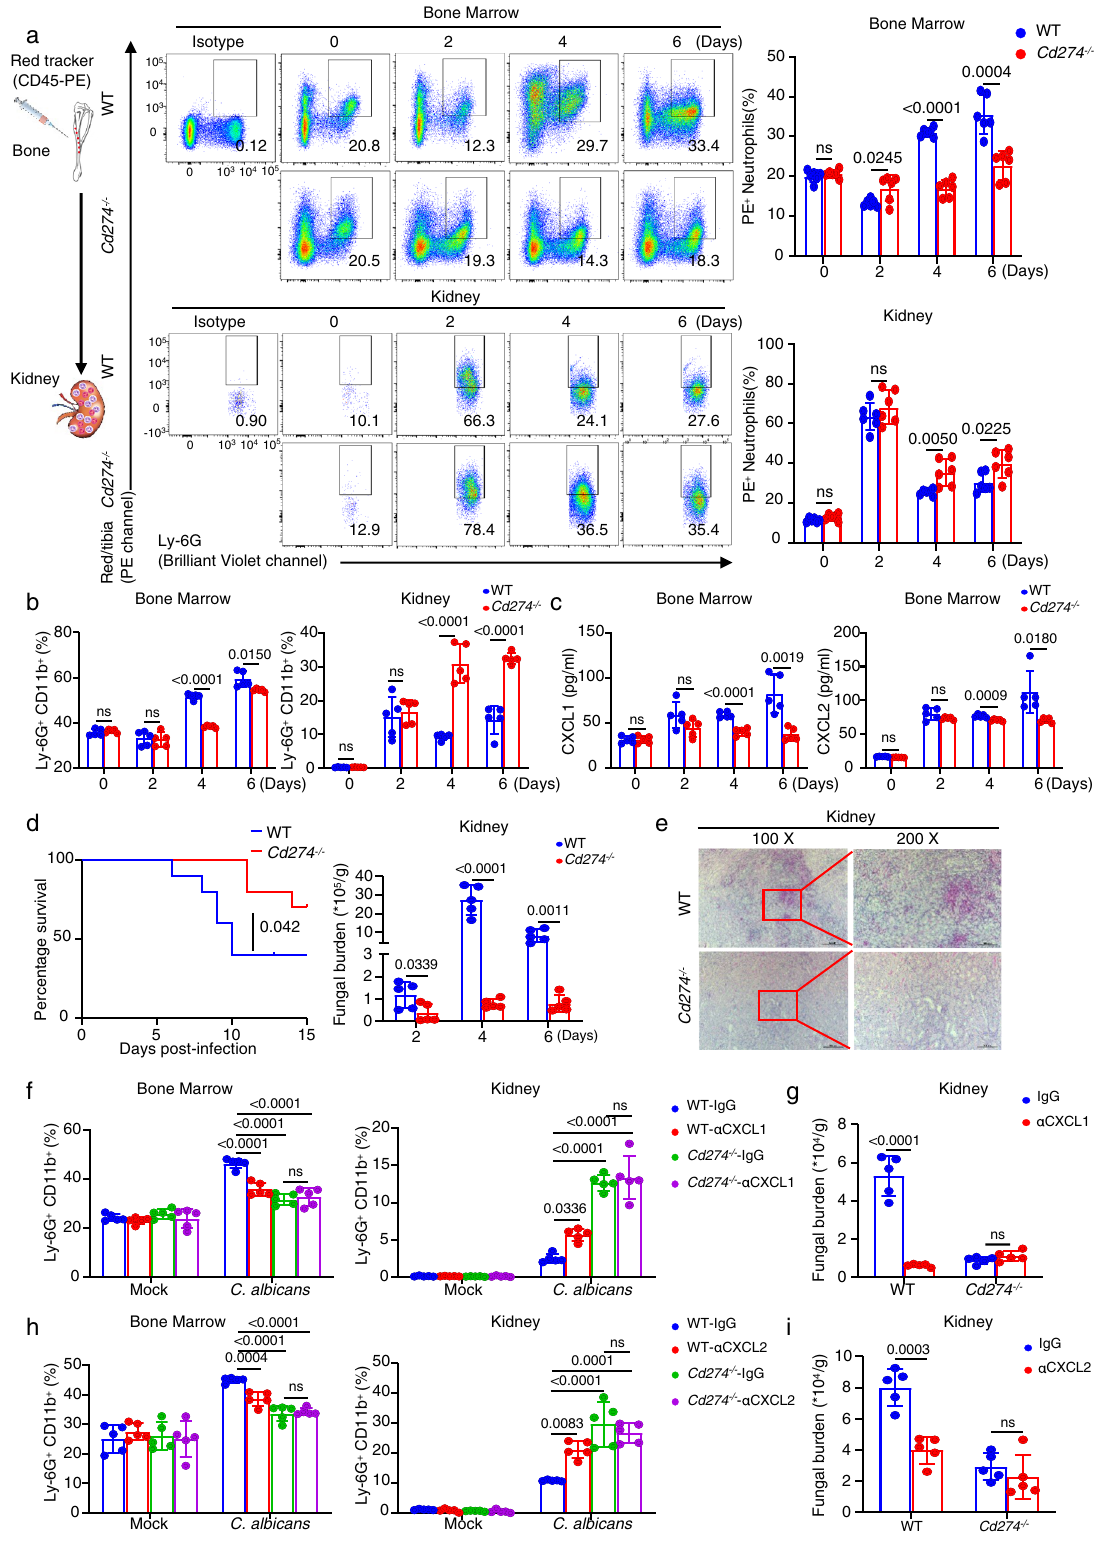
Red tracker (CD45-PE)